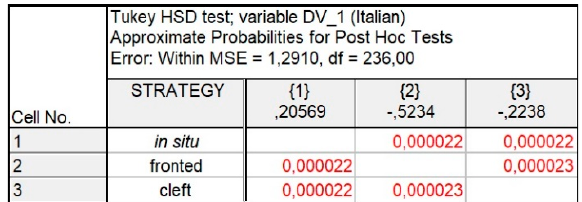
Figure 17. Strategy post hoc results (Italian) .